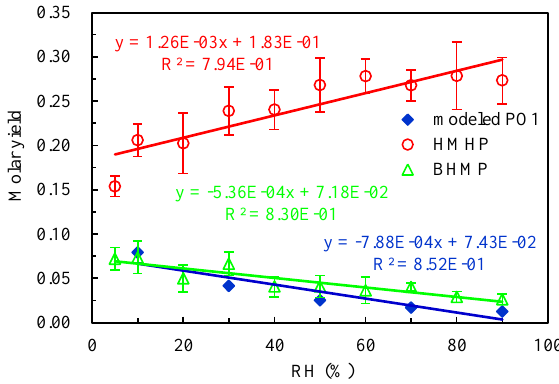
Fig. 9. Comparison of RH dependence profiles of measured HMHP, BHMP and modelled PO1 (i.e.,